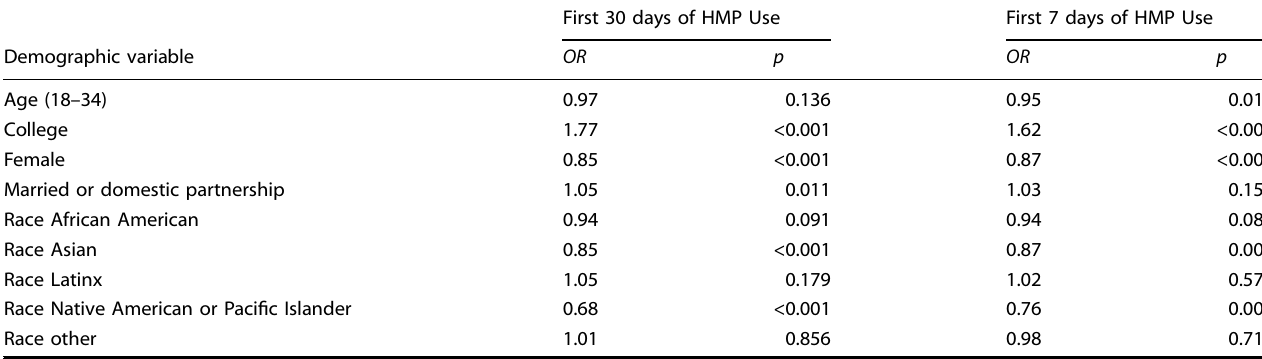
Table 4. Associations between demographic variables and likelihood of engaging in any meditation